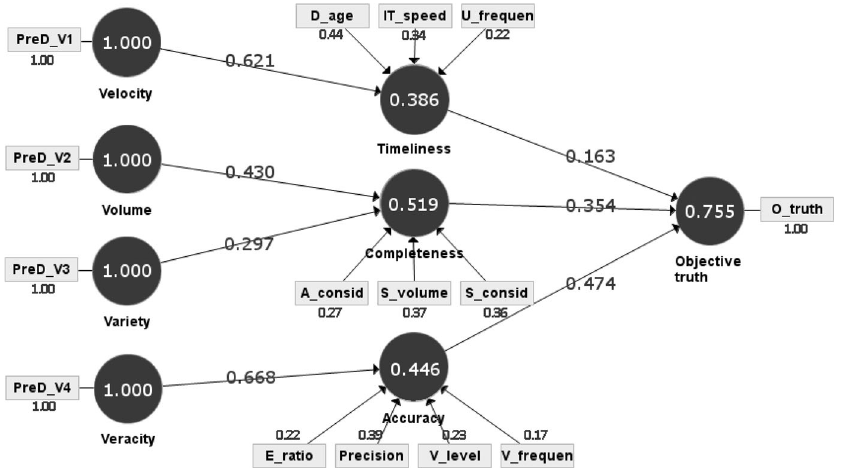
Fig. 3 Calculated structural equation